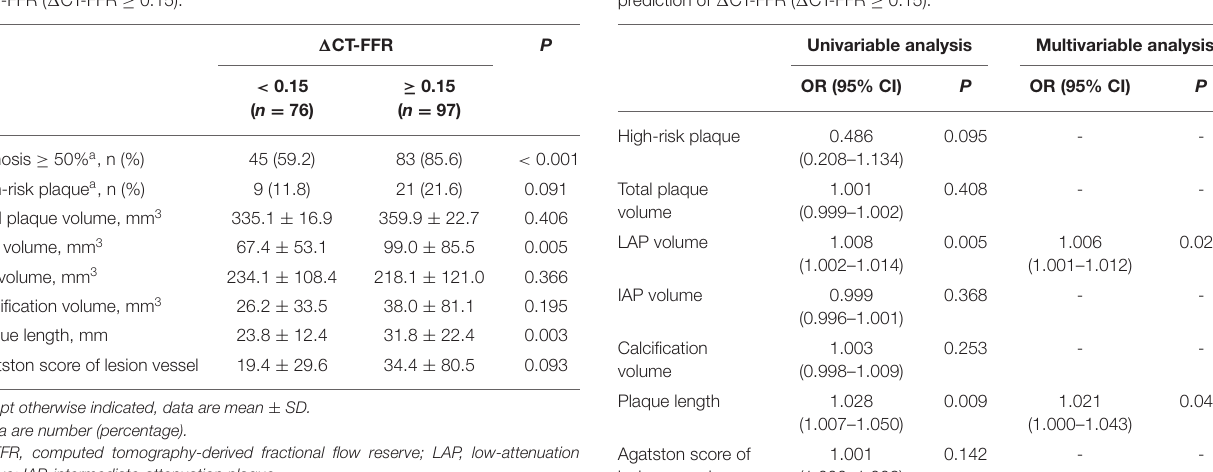
TABLE 5 | Univariable and multivariable analysis of plaque characteristics for prediction of 1 CT-FFR ( 1 CT-FFR ≥